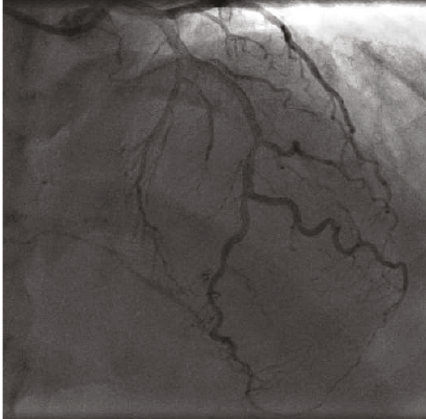
Figure 3: Left anterior descending artery (LAD) with collaterals to the right coronary artery (RCA).